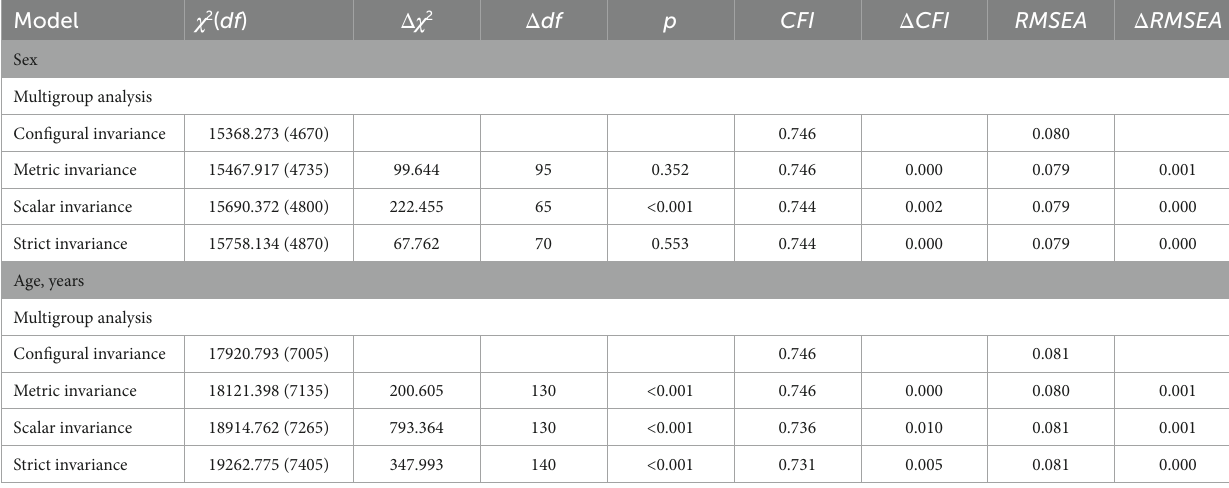
TABLE 3 Fit indices for the analysis of measurement invariance.